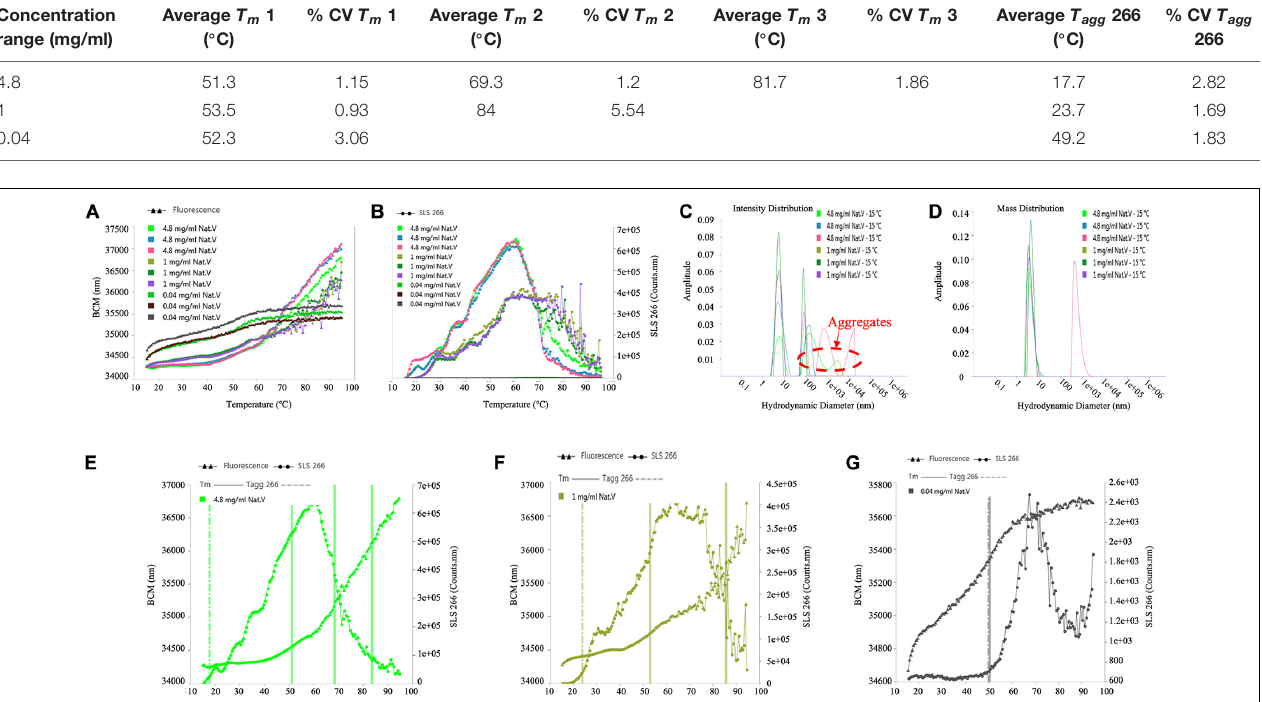
TABLE 2 | T m and T agg values determined for V. vulnificus N-acetyltransferase ( T m , the midpoint of the unfolding event; T m 1, T m 2, and T m 3, the first, second, and third transitions, respectively; T agg , the starting point of the aggregation event; T agg 266, static light scattering (SLS) signals recorded at 266 nm). Concentration range (mg/ml)